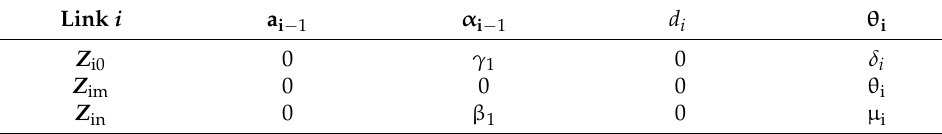
Figure 3. The position and direction of the frame U and definition of µ i . Table 1. Parameters of the link established by the D-H method.